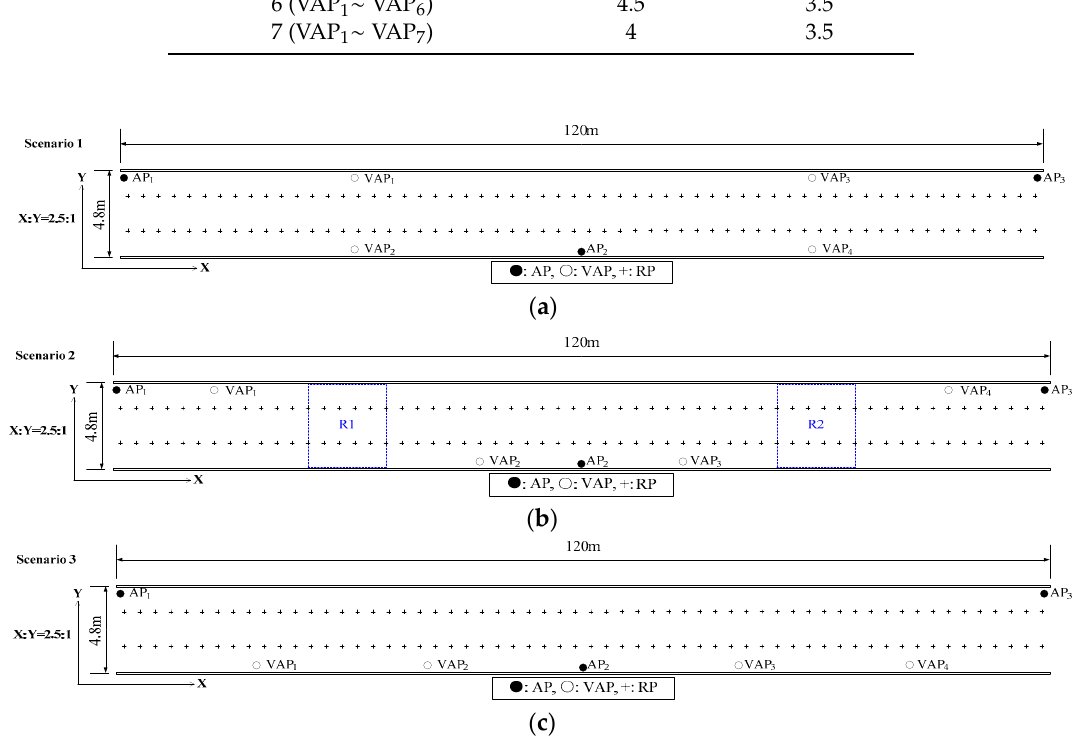
Figure 12. The experimental positioning scenarios using MA-VAP method under the same number